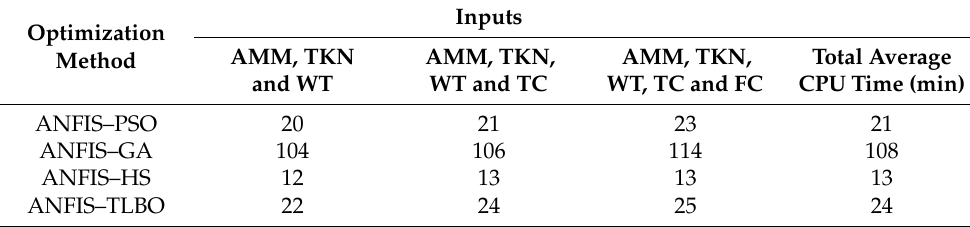
Table 9. Computational time (min) in predicting COD by the applied hybrid